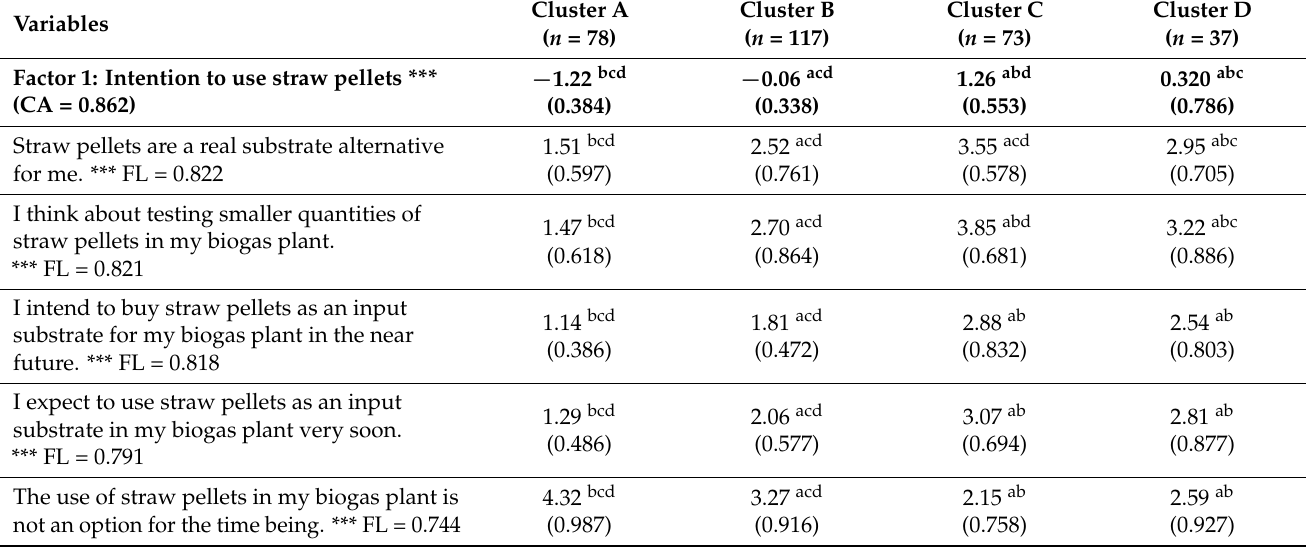
Table 2. Results of the factor and cluster